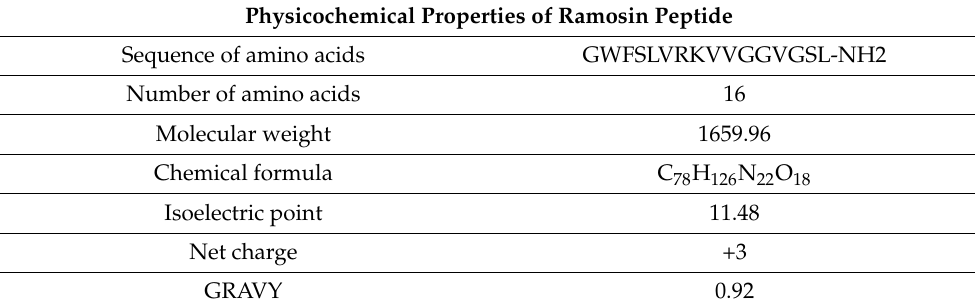
Table 4. Physicochemical properties of Ramosin peptide from B. ramosi.